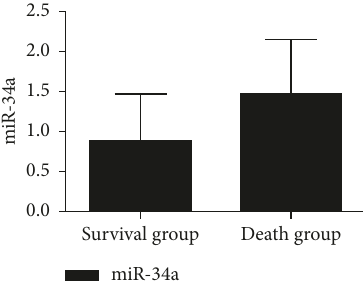
Figure 4: Comparison of serum miR-34a in children with RDS with different prognosis.